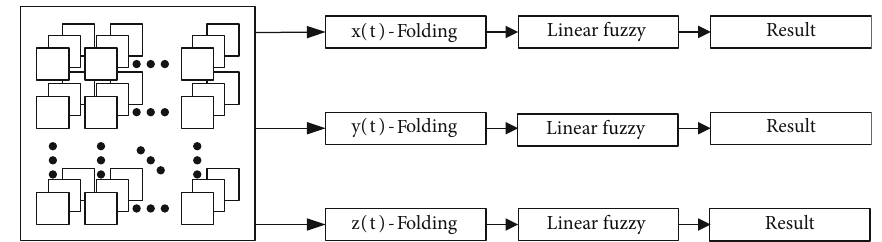
Figure 2: Schematic diagram of extraction algorithm